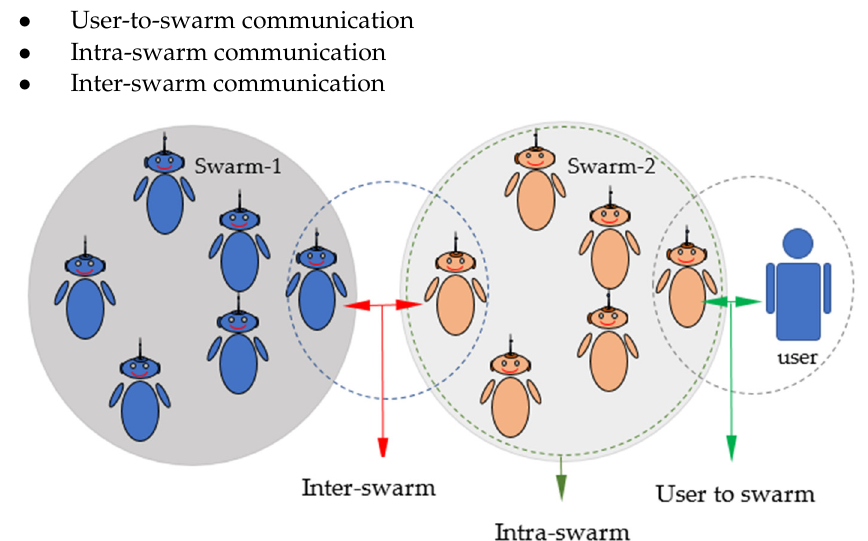
Figure 4. Communication models used in swarm robotics [26].